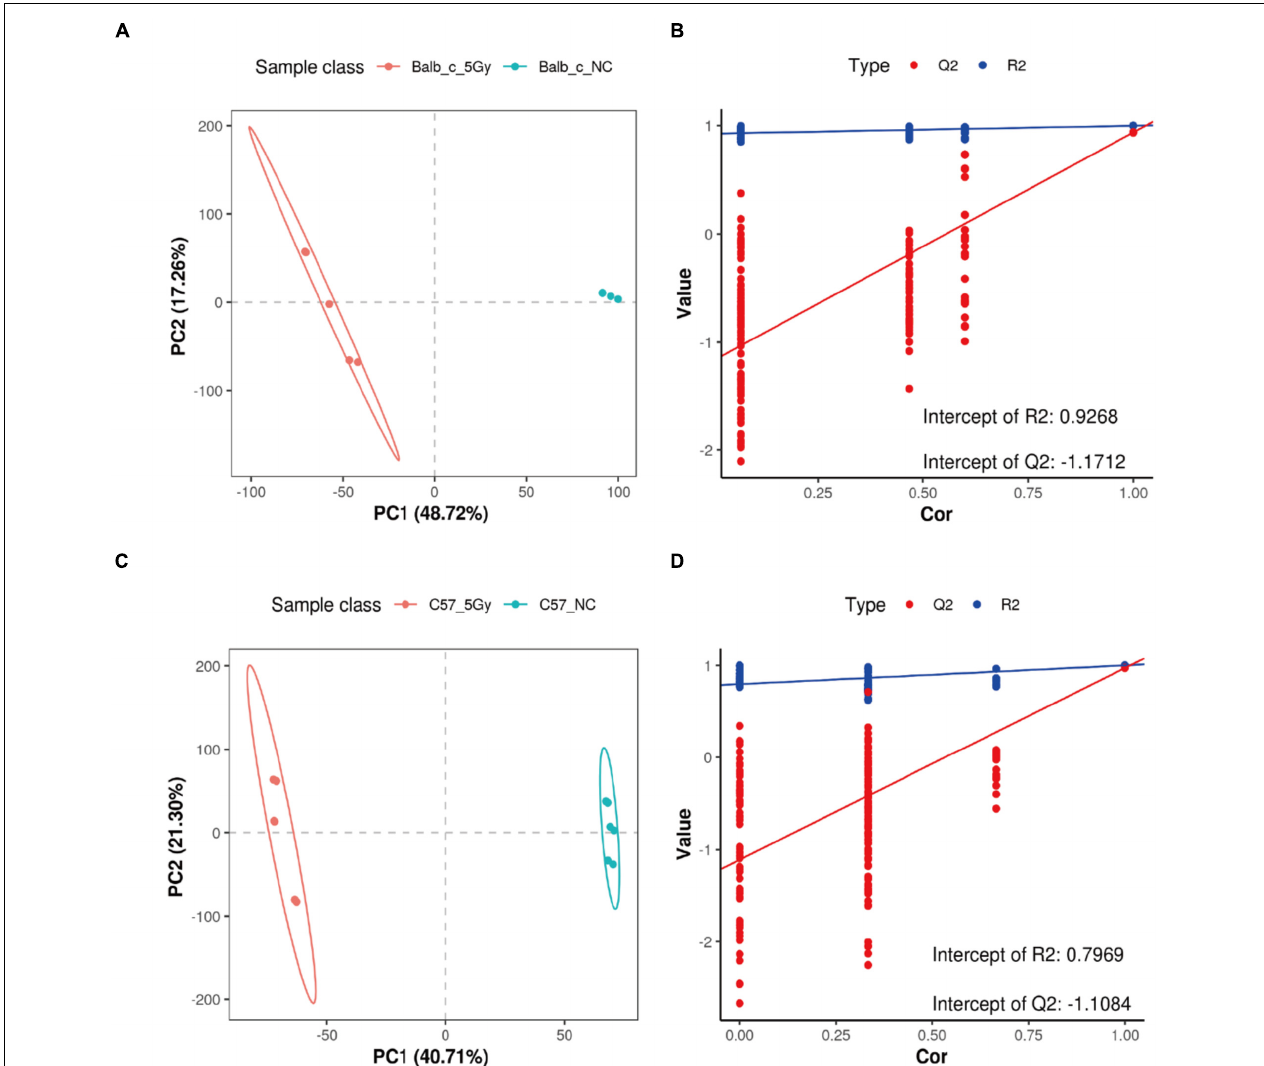
FIGURE 5 | Important discriminatory metabolites identified. PLSDA analysis displaying the grouped discrimination of the Balb/c-NC, Balb/c-5Gy, C57BL/6J-NC, and C57BL/6J-5Gy groups by the first two PCs. ( A,B : Balb/c-NC vs. Balb/c-5Gy; C,D : C57BL/6J-NC vs. C57BL/6J-5Gy) (Balb/c-NC: n = 3: Balb/c-5Gy: n = 6; C57BL/6J-NC: n = 6; C57BL/6J-5Gy: n =